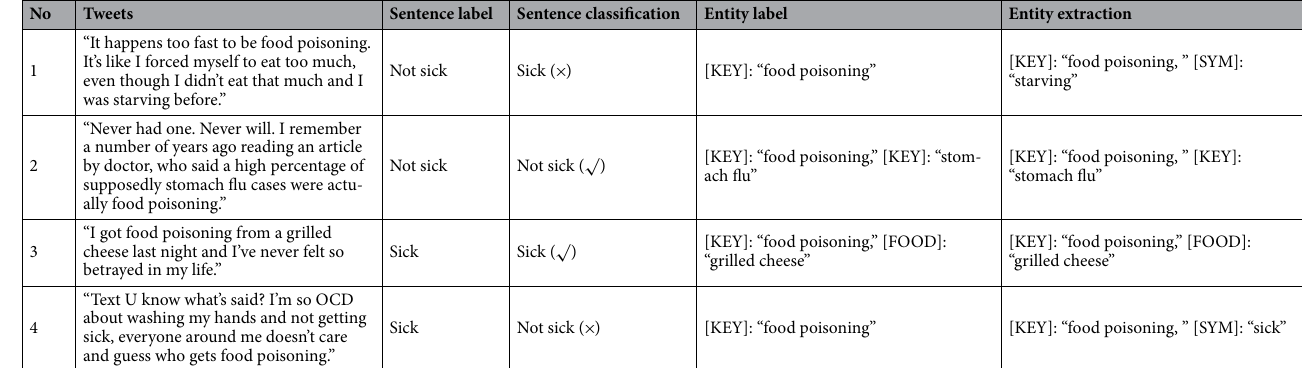
Table 2. Examples of tweets and predictions using the dual-task BERTweet model. × means incorrect √ predictions and means correct